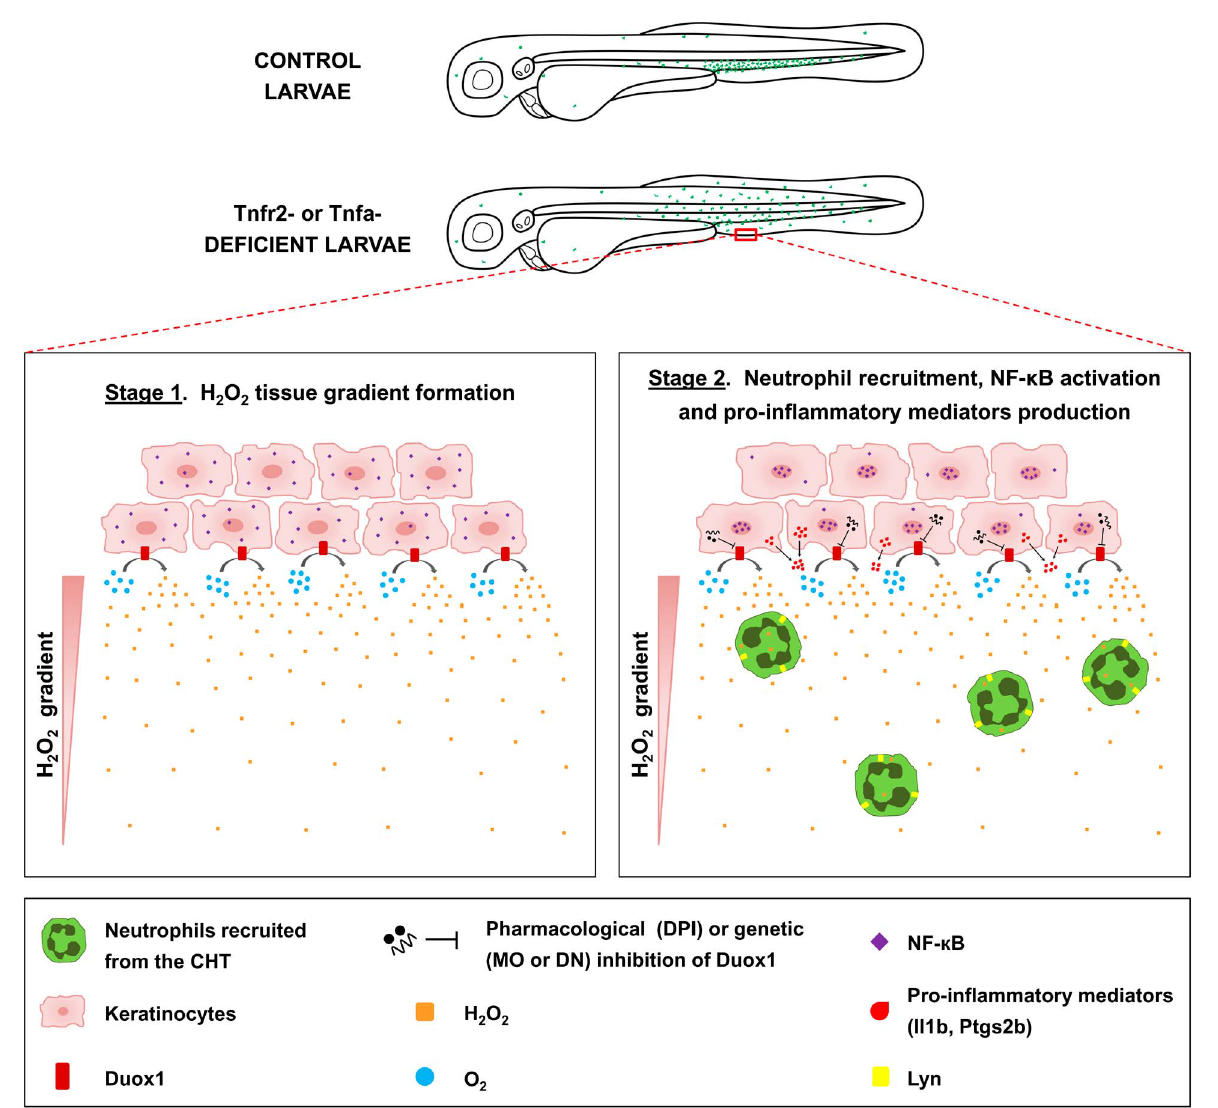
Figure 8. Proposed model illustrating the H 2 O 2 /NF- k B/Duox1 positive feedback inflammatory loop triggered in the skin of Tnfa- or Tnfr2-deficient zebrafish. Stage 1 (left panel): Tnfa or Tnfr2 deficiency triggers Duox1-dependent release of H 2 O 2 , which in turn promotes Lyn- mediated neutrophil infiltration. Stage 2 (right panel): H 2 O 2 induces the activation of NF- k B, which is then translocated to the nucleus and induces the activation of genes encoding pro-inflammatory mediators (Il1b, Ptgs2, and probably Duox1). Pharmacological or genetic inhibition of Duox1 restores skin homeostasis.